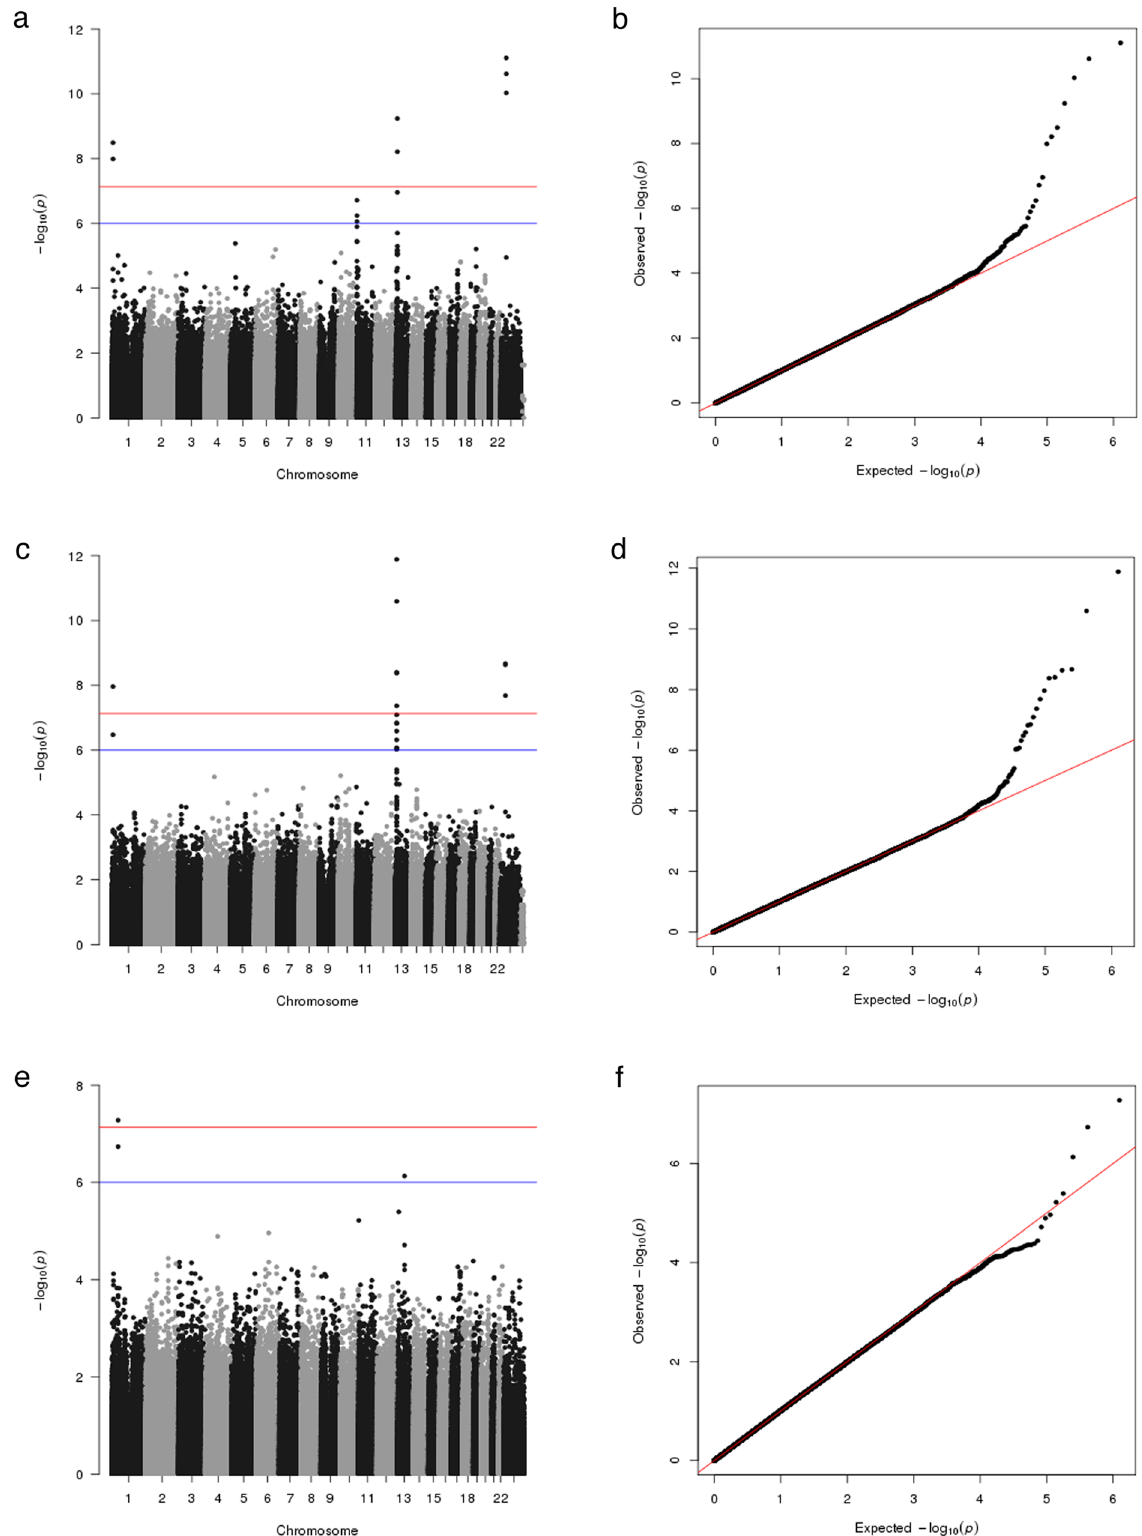
Fig. 1 | Results of the discovery-stage genome-wide association study. Man- hattanplots( a , c , e )andquantile-quantile(QQ)plots( b , d , f )showingresultsforthe entire discoverycohort( a , b ) and subanalyses for men ( c , d ) and women ( e , f ).For the entire discovery cohort, three loci with genome-wide signi fi cance ( P <7.36×10 − 8 ) on chromosome 1, 13, and X and a fourth locus on chromosome 11